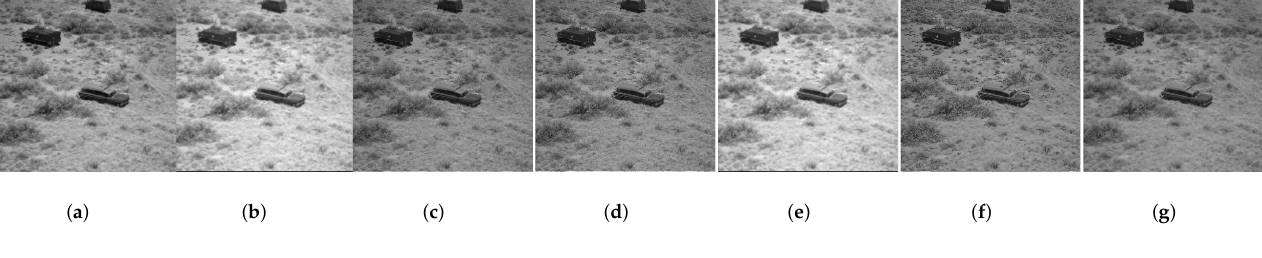
Figure 9. The renderings of trucks image under different algorithms. ( a ) Original image. ( b ) 1-order.